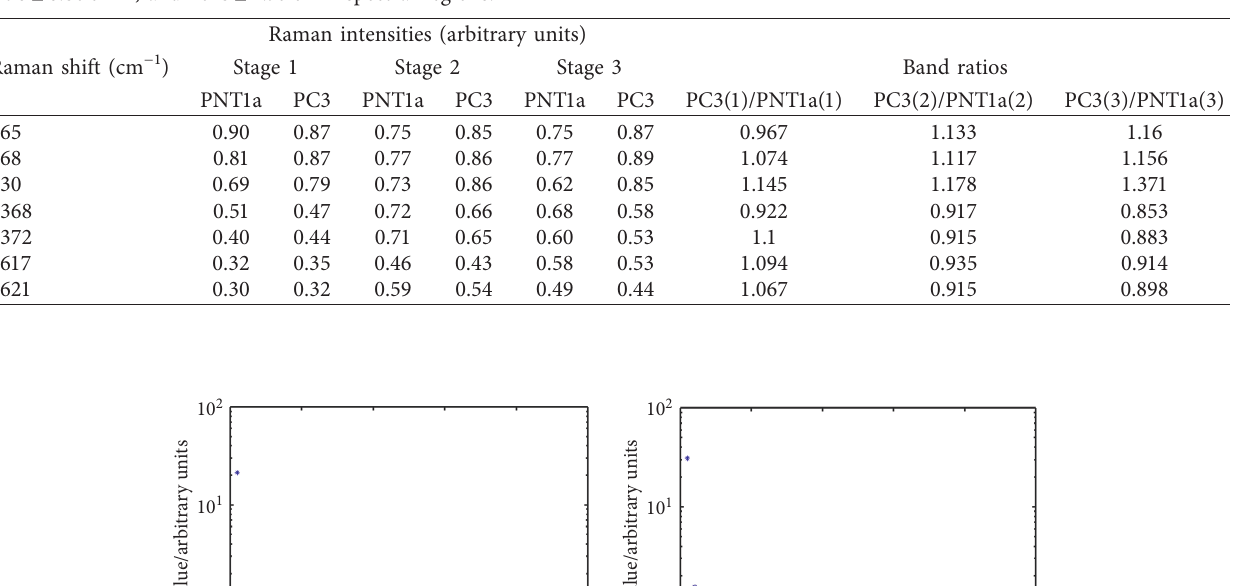
Table 2: Comparison of peak intensity ratios between malignant (PC3) and normal cells (PNT1a) at 566 ± 0.70cm − 1 , 630cm − 1 , 1370 ± 0.86cm − 1 , and 1618 ± 1.73cm − 1 spectral